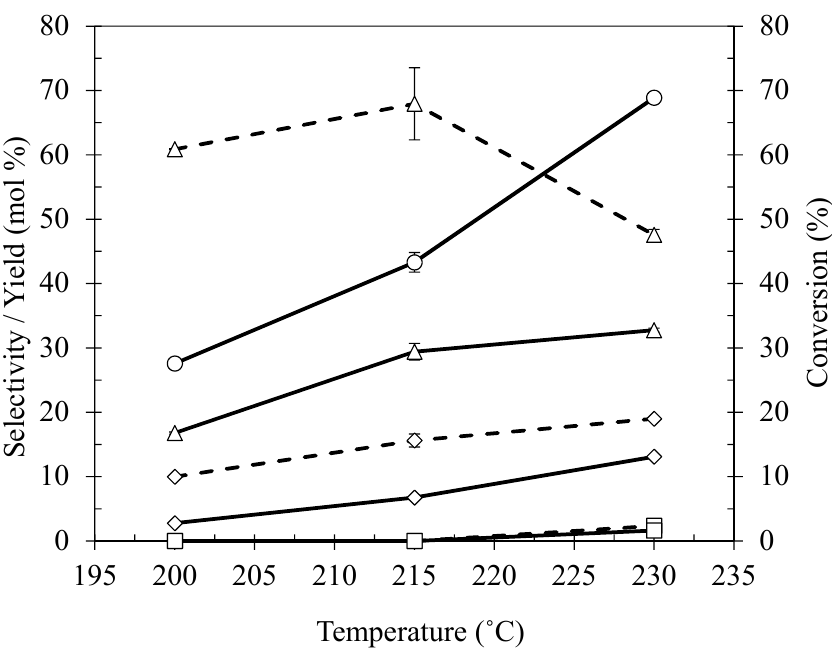
Figure 4. Effect of reaction temperature on the activity of 25 wt % Ni/Ce–Mg (9:1 mol/mol) catalysts prepared by DP and calcined at 350 °C. Reaction conditions: reactant 100 g (60 wt % glycerol in H 2 O), 10 g catalyst, hydrogen initial pressure pH 2 = 6.9 MPa, and reaction time t = 24 h. Legend: solid lines for glycerol conversion and product yields, dashed lines for product selectivity, ( ○ ) glycerol conversion, ( ) ethanol, ( □ ) n -propanol, ( Δ ) 1,2-PDO. Error bars are based on the average values of duplicate experimental data.